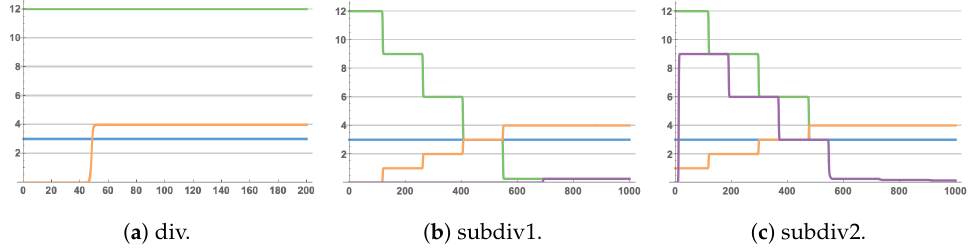
Figure 2. Dynamic simulation of the solution results of solving AX = B of the three methods, ( a ) where A ( 0 ) = 3 (blue), B ( 0 ) = 12 (green), solution result of X = 4 (orange); ( b ) the remainder is r = 0.259458 (purple); ( c ) the remainder is r = 0.1472 (purple). The abscissa represents the time unit is seconds.